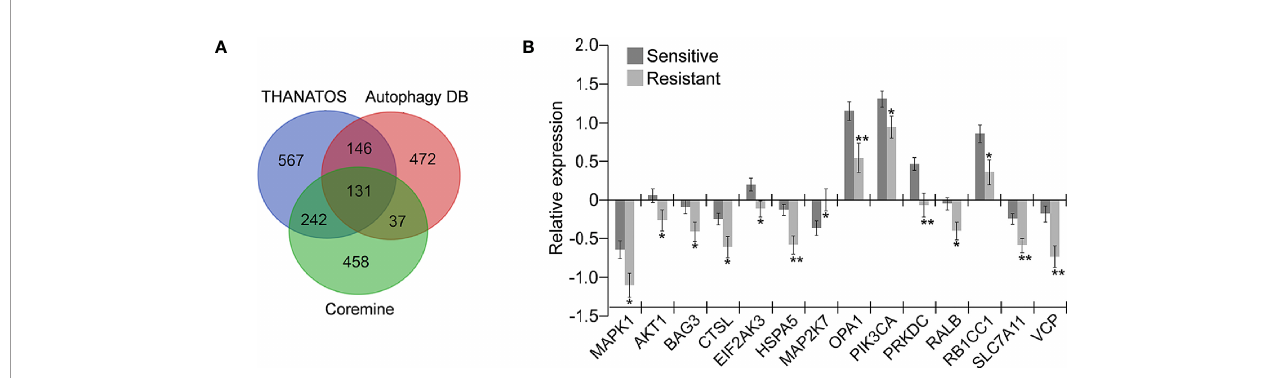
FIGURE 1 | Identi fi cation of genes potentially related to autophagy and drug resistance in ovarian cancer (OC). (A) The 131 overlapping genes involved in autophagy and drug resistance were retrieved from three independent databases. A total of 786 and 1086 autophagy-related genes were retrieved from database Autophagy DB and Thanatos, respectively. 868 genes related to OC drug resistance and autophagy were selected through text mining conducted by Coremine (P < 0.05); (B) Fourteen of the above 131 genes were signi fi cantly dysregulated in chemoresistant OC tissues (Resistant, n=90) compared with the sensitive tissues (Sensitive, n=197) according to the TCGA ovarian cohort (* P < 0.05; ** P <